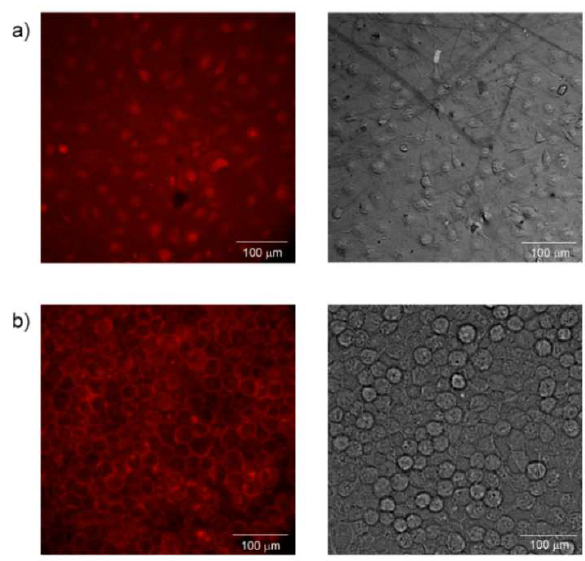
Figure 3. Mouse embryonic fibroblasts L929 growing on the surface of ( a ) pristine polytetrafluoroethylene and ( b ) polytetrafluoroethylene coated by Au nanolayer. Images were taken by fluorescent microscope at magnification of 40×.